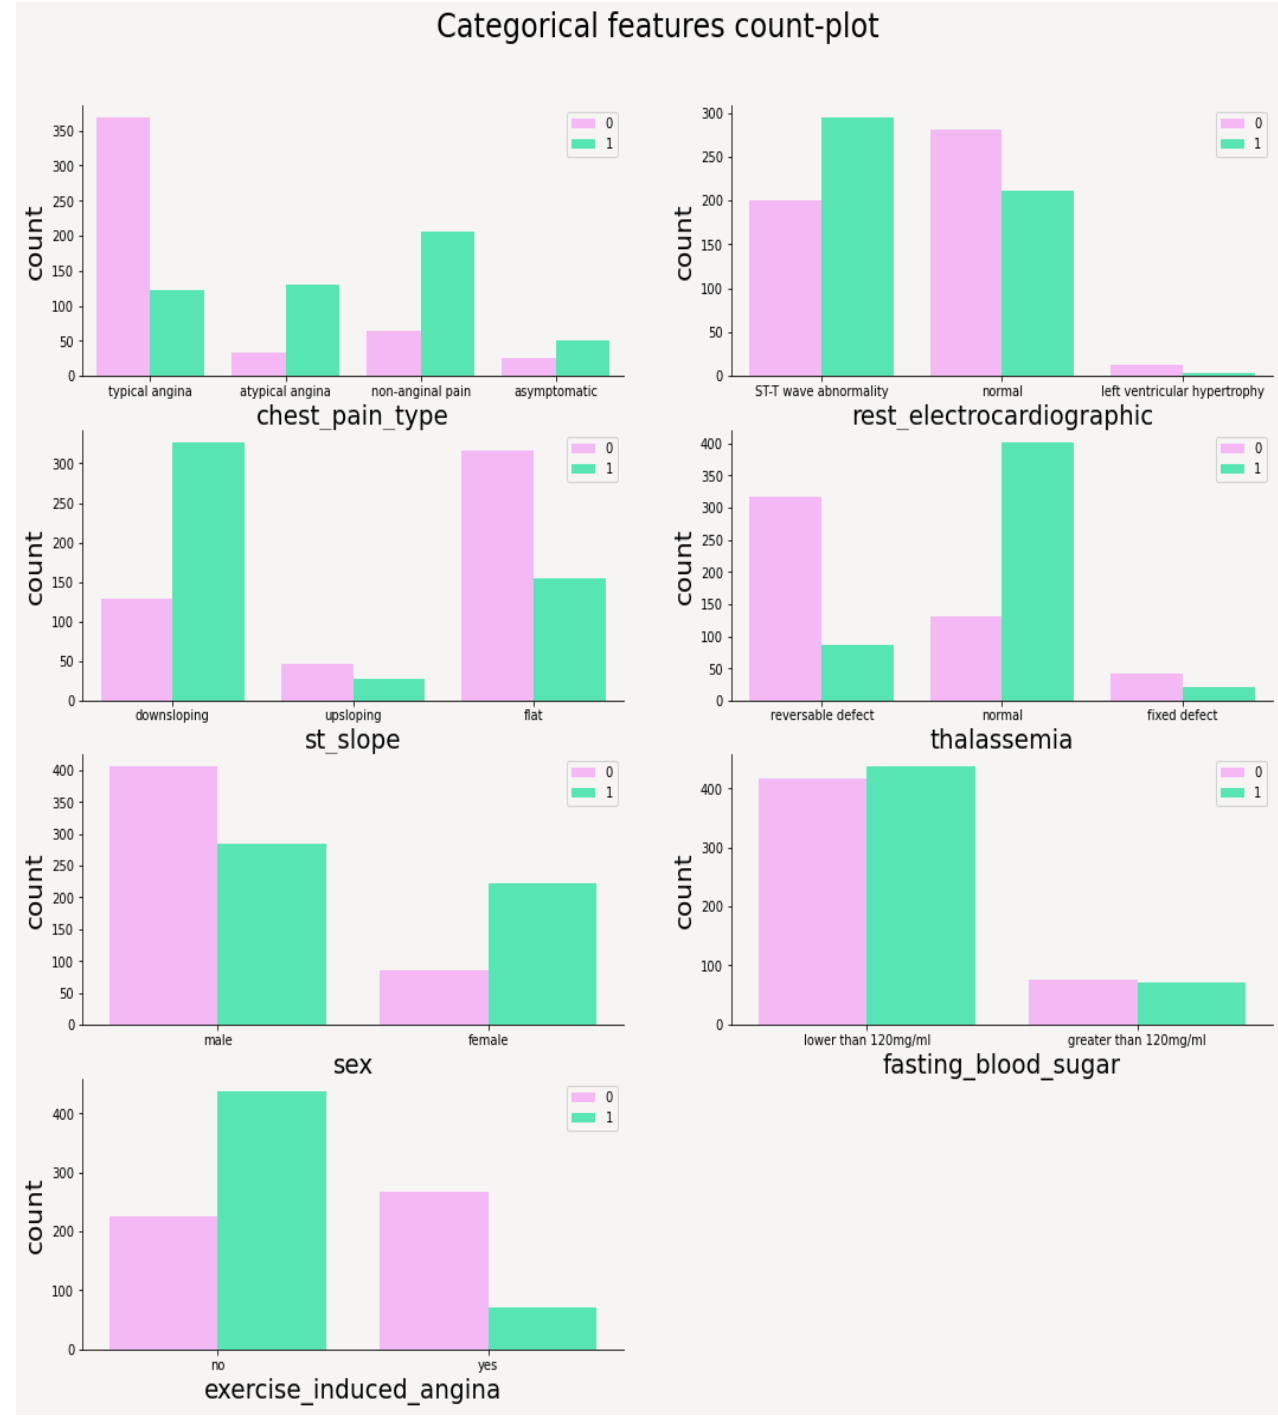
Figure 7. Categorical features count plots of the Data.